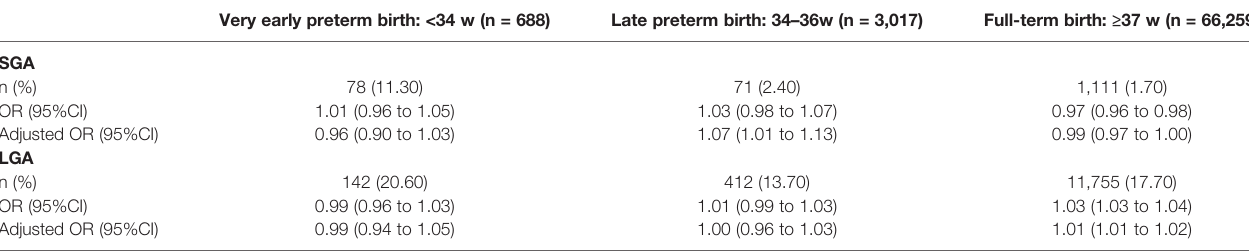
TABLE 3 | Per-Unit Increase of paternal age and Risks of SGA and LGA by preterm and full-term birth group.